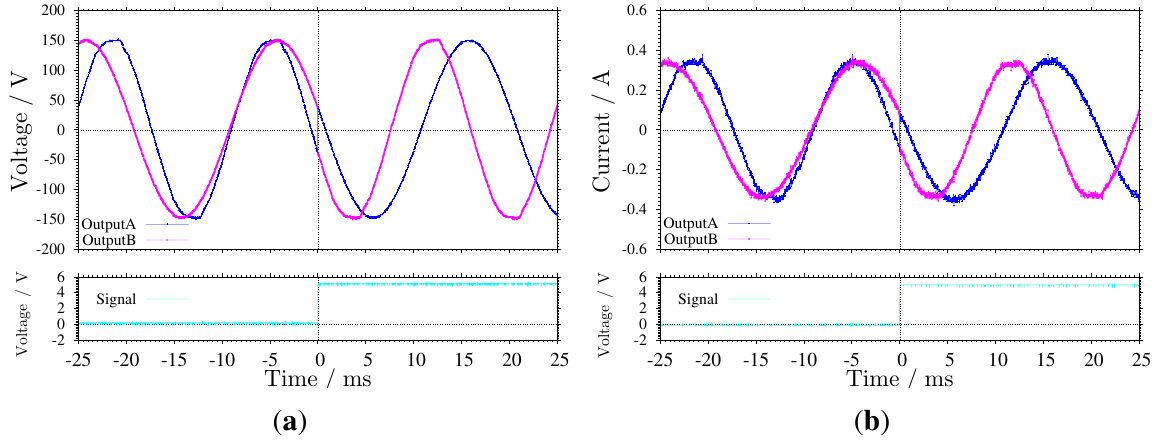
Figure 8. Output waveforms in parallel connection. Light-emitting diode (LED) bulbs are set as loads: ( a ) output voltage waveforms; and ( b ) output current